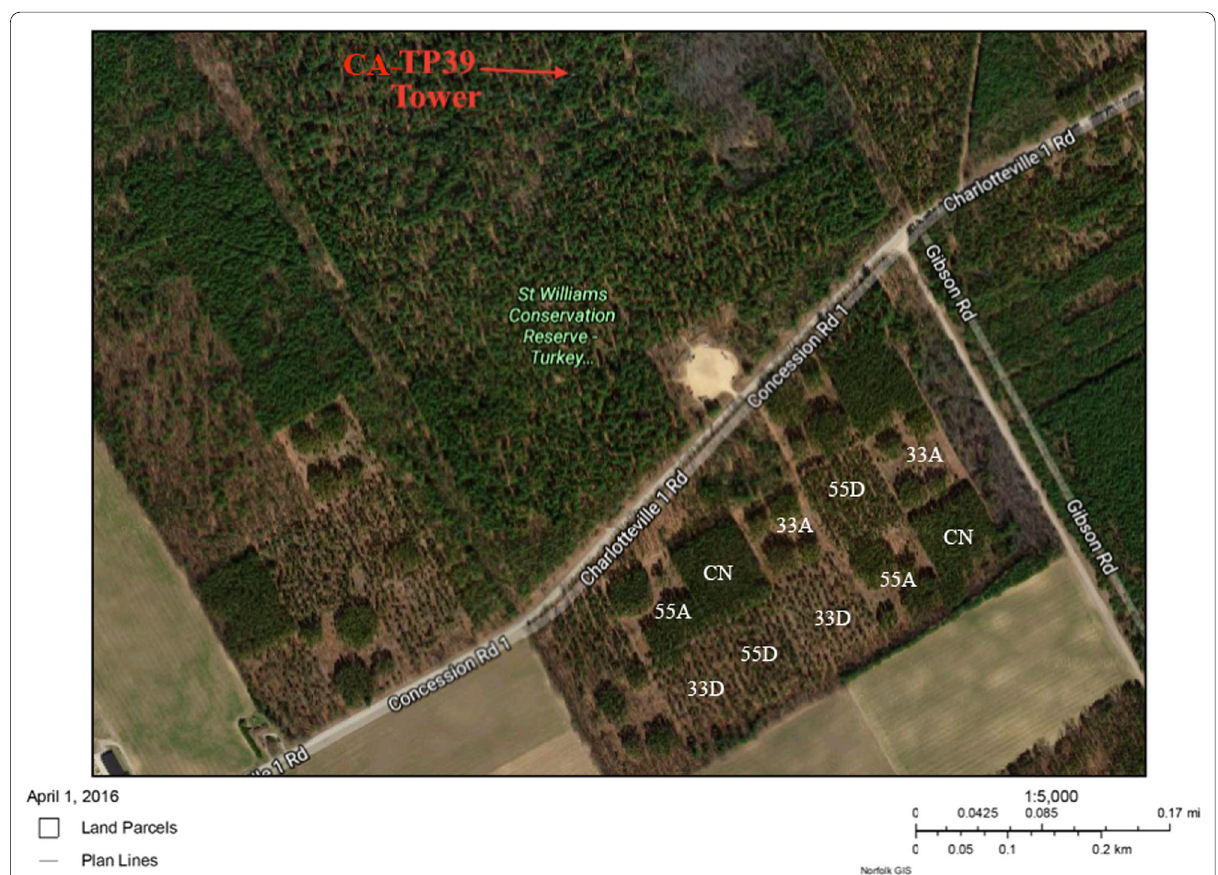
Fig. 1 Aerial photograph of CA-TP39 and CA-TP31 study area obtained from Google Earth 2016 showing the various 1-ha VRH treatments